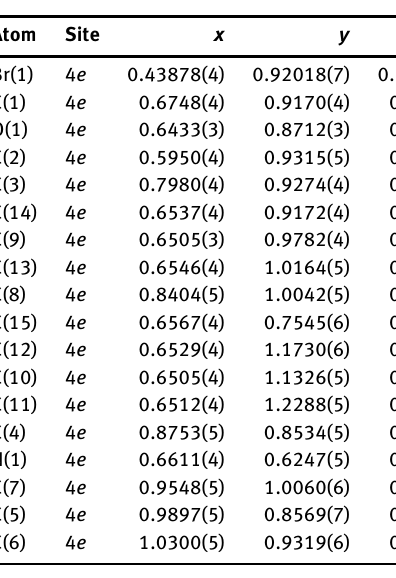
Table 3: Atomic displacement parameters (Å 2